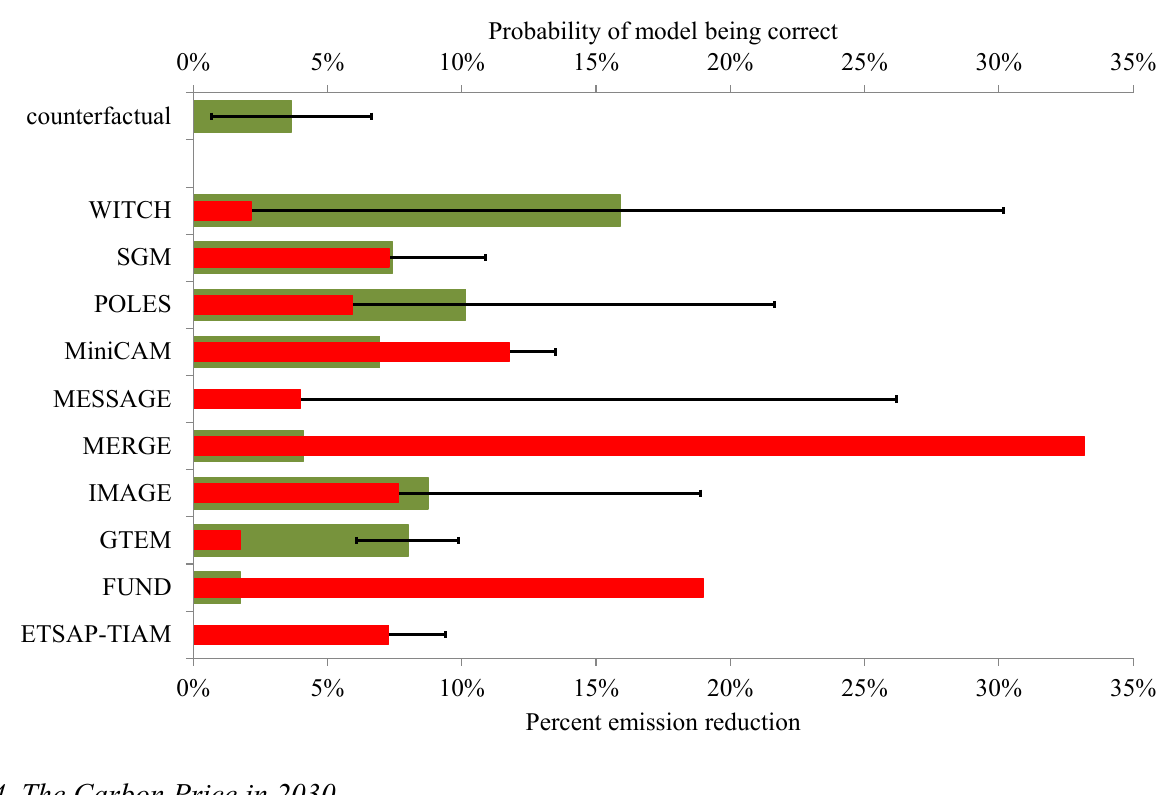
Figure 2. The estimated emission reduction (due to the observed $13/tCO 2 carbon price; dark green bar at the top), the predicted emission reduction per model (or rather its statistical emulator; dark green bars), and the probability of the model being correct (light right inset); the lines indicate the 95% confidence